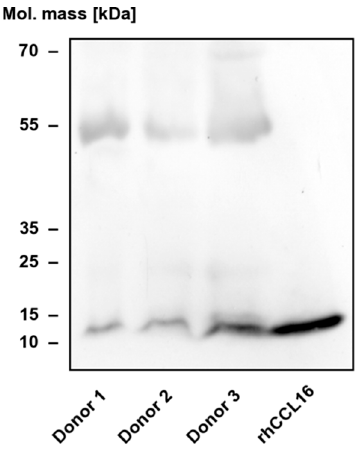
Figure 7. Enrichment of CCL16 from human serum. Heparin-binding proteins were enriched from the sera of human subjects ( n = 3) via heparin affinity chromatography. Expression was determined by immunoblotting analysis using a polyclonal goat anti-human CCL16 antibody. As a control, the fourth lane contains 0.4 ng of recombinant human (rh) CCL16. The identity of the immunoreactive band with about 55 kDa apparent mass is unknown.